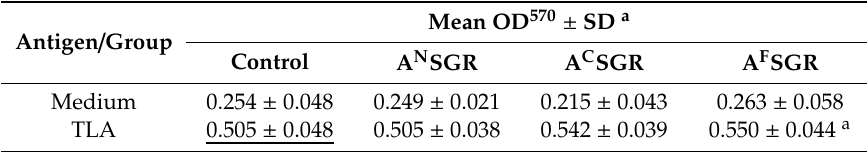
Table 2. Proliferative responses of splenocytes from vaccinated and control mice stimulated with TLA in